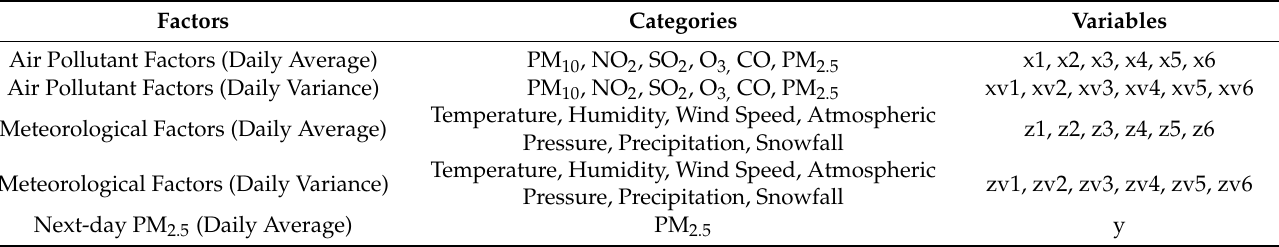
Table 1. Variables for prediction model